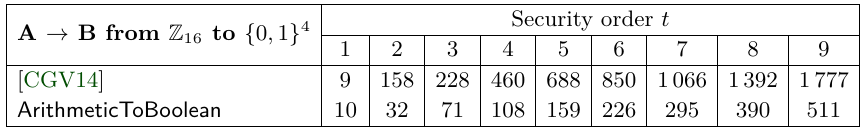
Table 14: Number of cycles to perform an arithmetic modulo 2 k to k -bit Boolean conversion with k =